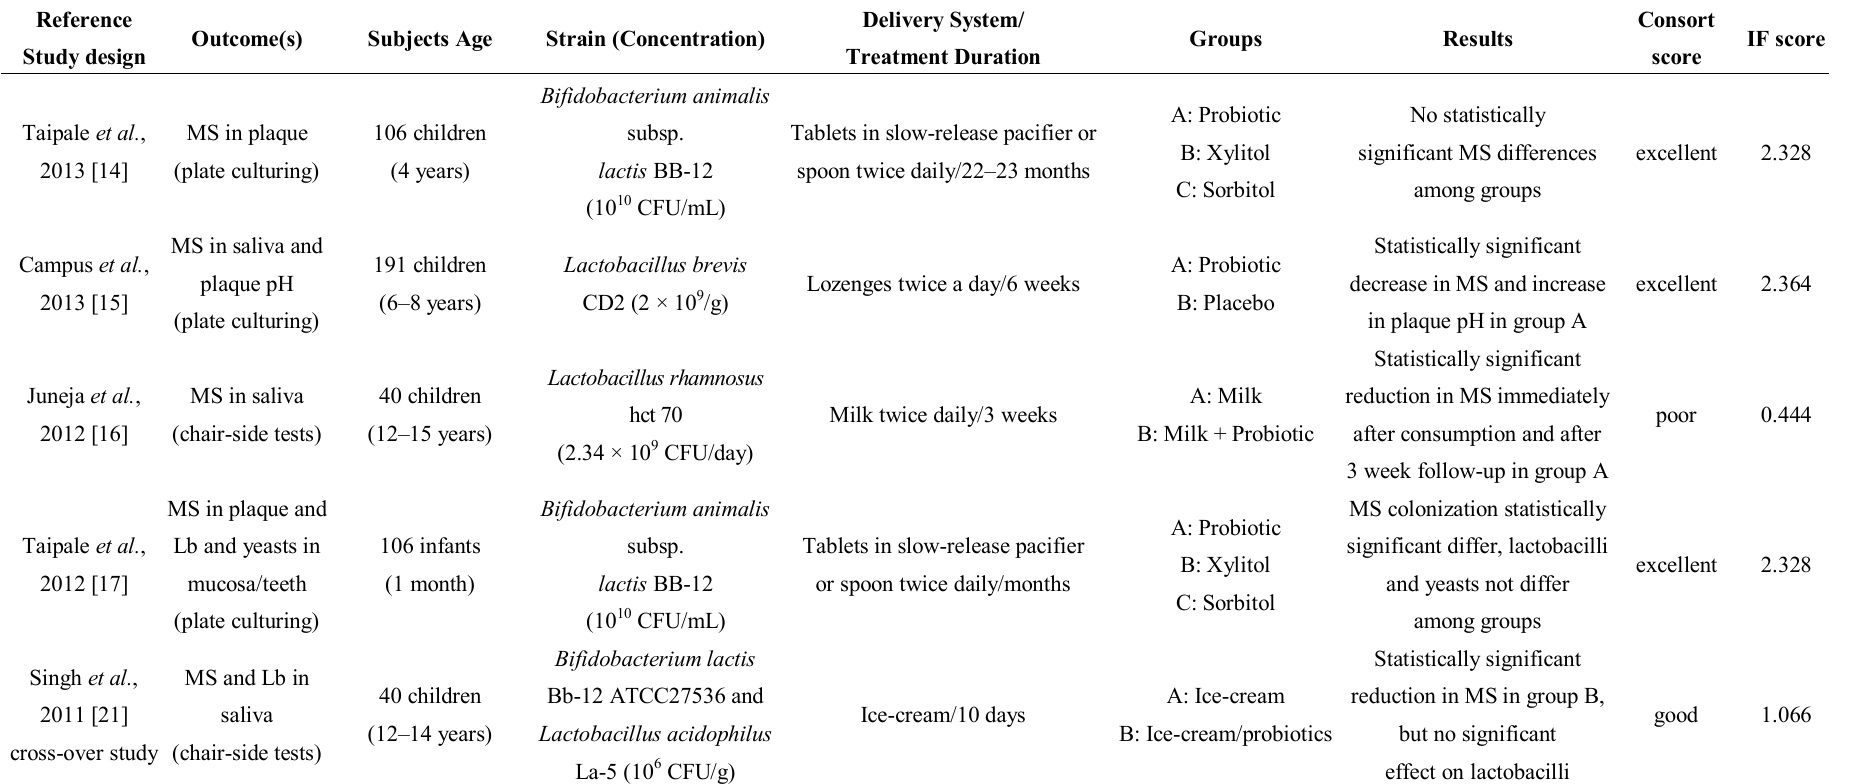
Table 2. Studies with caries risk factors as outcome